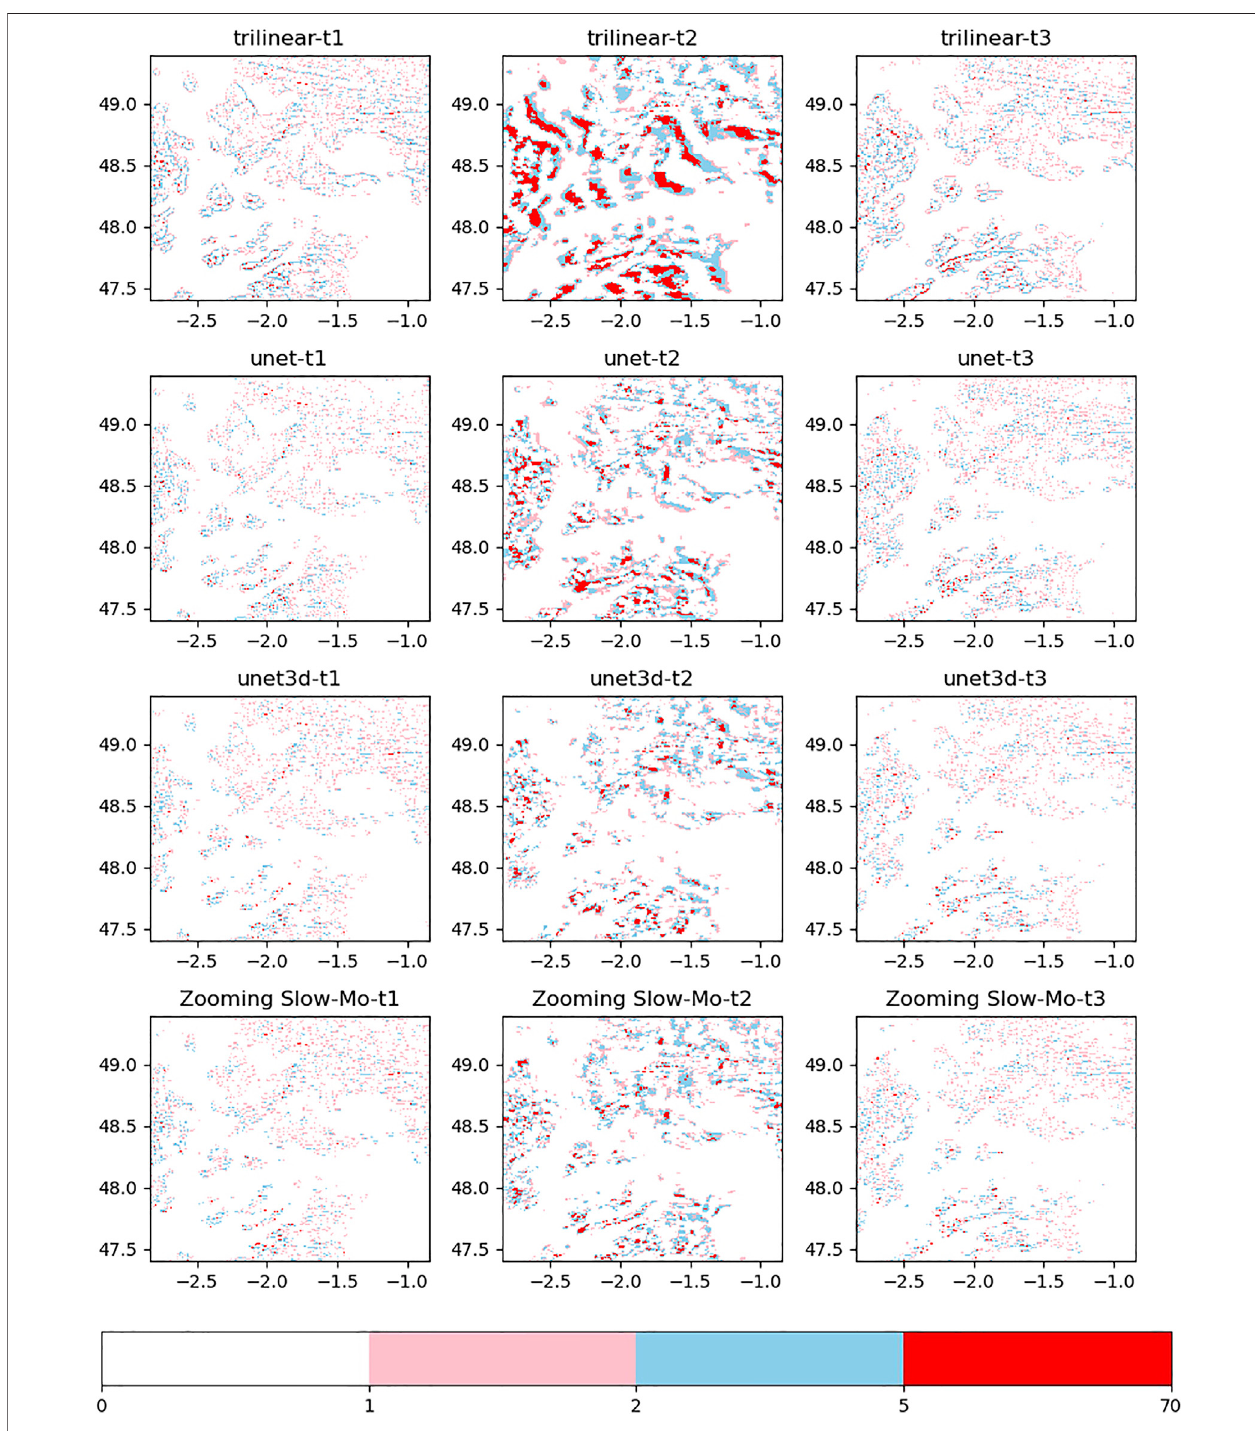
FIGURE 9 | Image of the difference between the prediction and the real